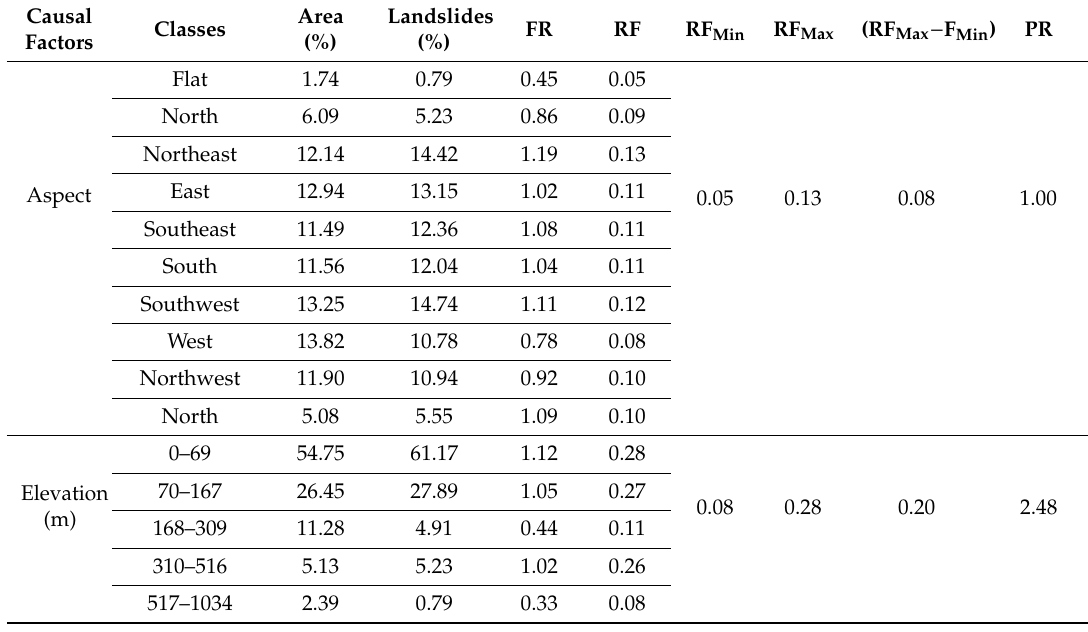
Table 2. Frequency ratios of landslide predisposing